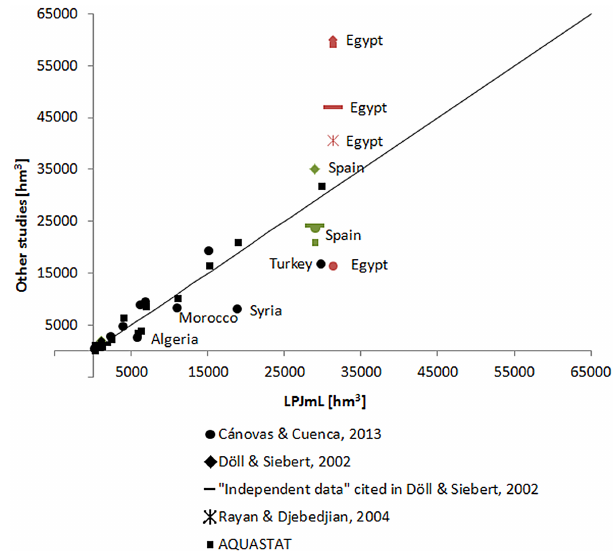
Figure 4. Scatter plot of LPJmL-simulated gross irrigation water re- quirements (hm 3 , averages over 2000–2009) and the estimates pre- sented by other studies. The line represents the 1 : 1 line. Egypt and Spain have been coloured in red and green, respectively, to visu- alise the disparities between different studies. (Note that Cánovas Cuenca, 2013, assumes a fixed requirement of 6176m 3 ha − 1